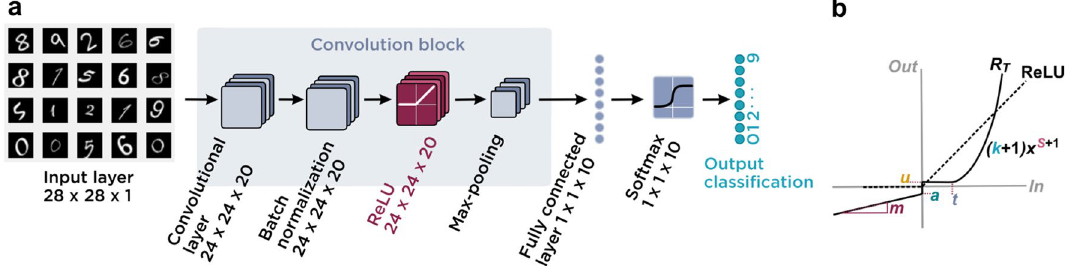
Figure 2. Convolutional neural network (CNN) architecture and ReLU parameter fitting. ( a ) Schematic representation of the CNN architecture and its input dataset (shown here as a screenshot of a subset of the MATLAB input data—see “Methods”). The activation functions studied are included in the ReLU layer. ( b ) Graphical representation of the parametrized activation function, “total distorted ReLU” ( R T ), used in the ReLU layer. Distortion was introduced via parameters responsible for: scaling ( k ), vertical translation ( u ), reverse leakage ( a , m ), horizontal translation or threshold ( t ), and polynomial behavior ( s